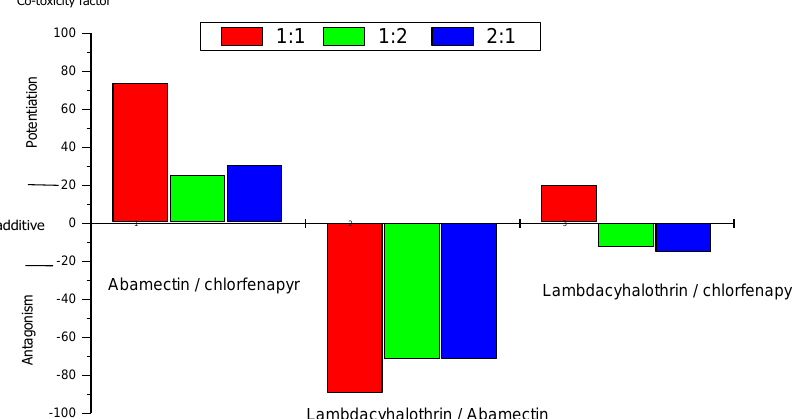
Figure 1. The effect of binary mixture LC 25 between tested insecticides against larvae after 24 h.